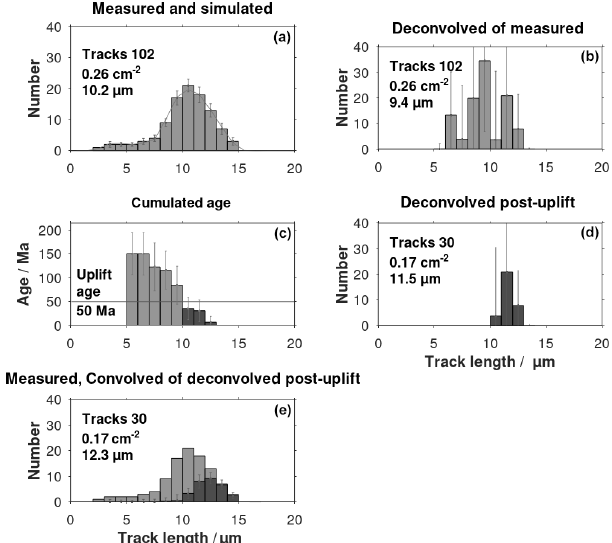
Figure 3. (a) The forward-simulated track length histogram re- sembling a measured histogram, (b) the deconvolved histogram of the measured histogram, and (c) the cumulated age histogram are shown. The dark grey columns identify the post-depositional tracks. Panel (d) shows the post-uplift columns of the deconvolved histogram. (e) The convolution (spreading out) of the deconvolved post-uplift histogram is like the post-uplift part (dark grey) of a mea- sured track length